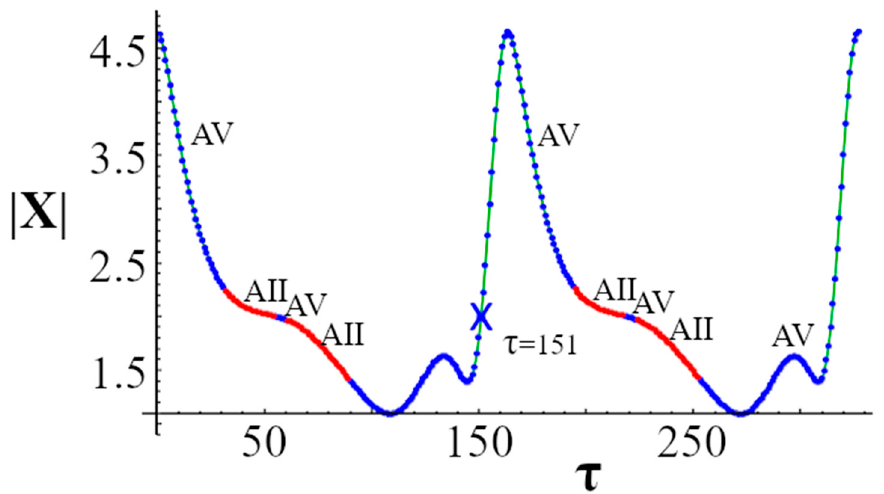
Figure 10. Power-shift method applying a linear ramp with T lag = 15 , Y 0 = 1.63 for base AIII with Y PS = 1.84 . The blue X marks the center of the largest time interval which power shift to AV. Two periods are displayed for clarity.